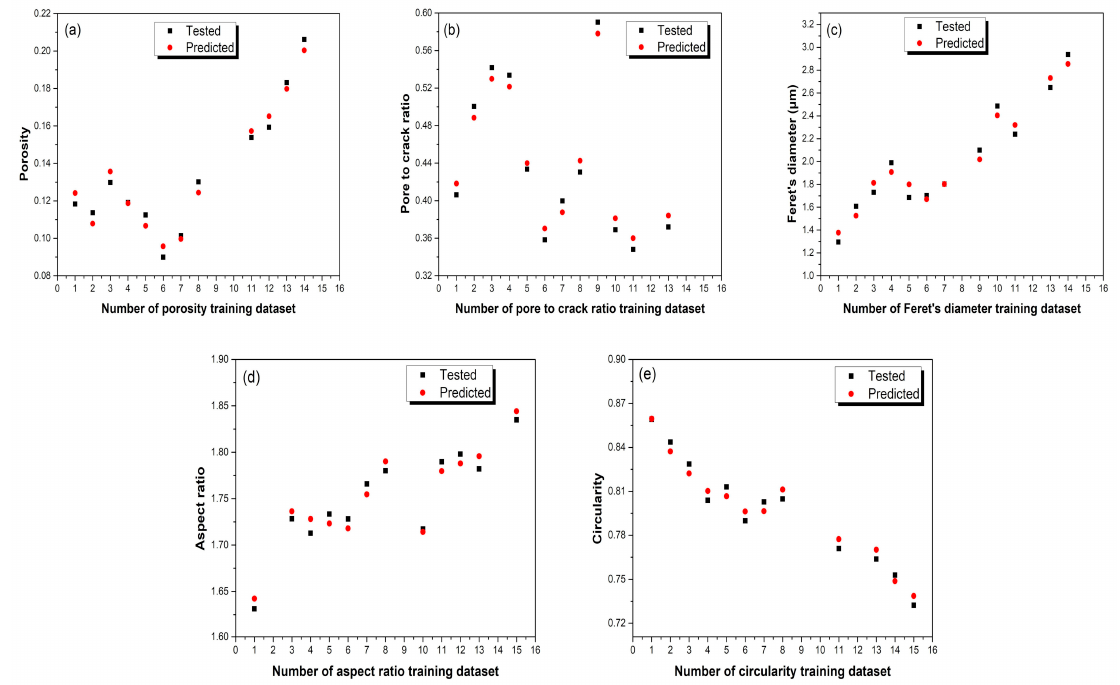
Figure 3. The testing results and the prediction results of the microstructural features of the CS-SVM training model. ( a ) Porosity; ( b ) pore-to-crack ratio; ( c ) maximum Feret’s diameter; ( d ) aspect ratio; ( e ) circularity.